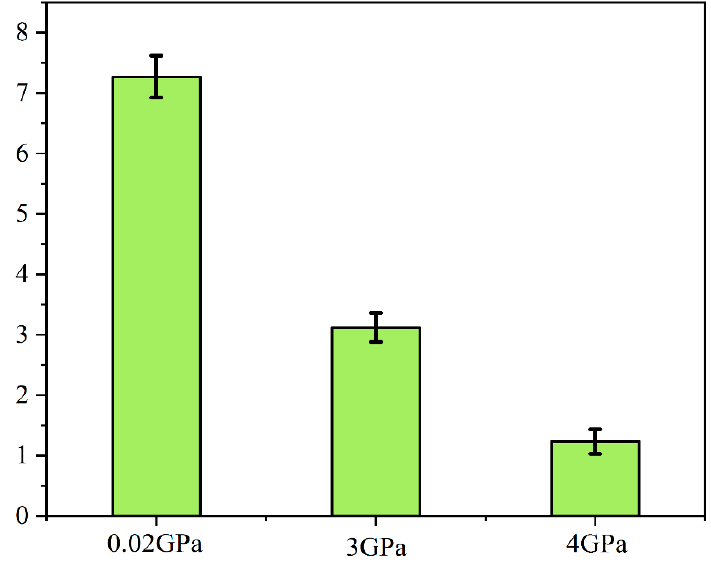
Figure 4. Al 2 O 3 /Al-20Si composite eutectic Si morphology ( a , b ) 0.02 GPa, ( c ) 3 GPa, ( d ) 4 GPa.